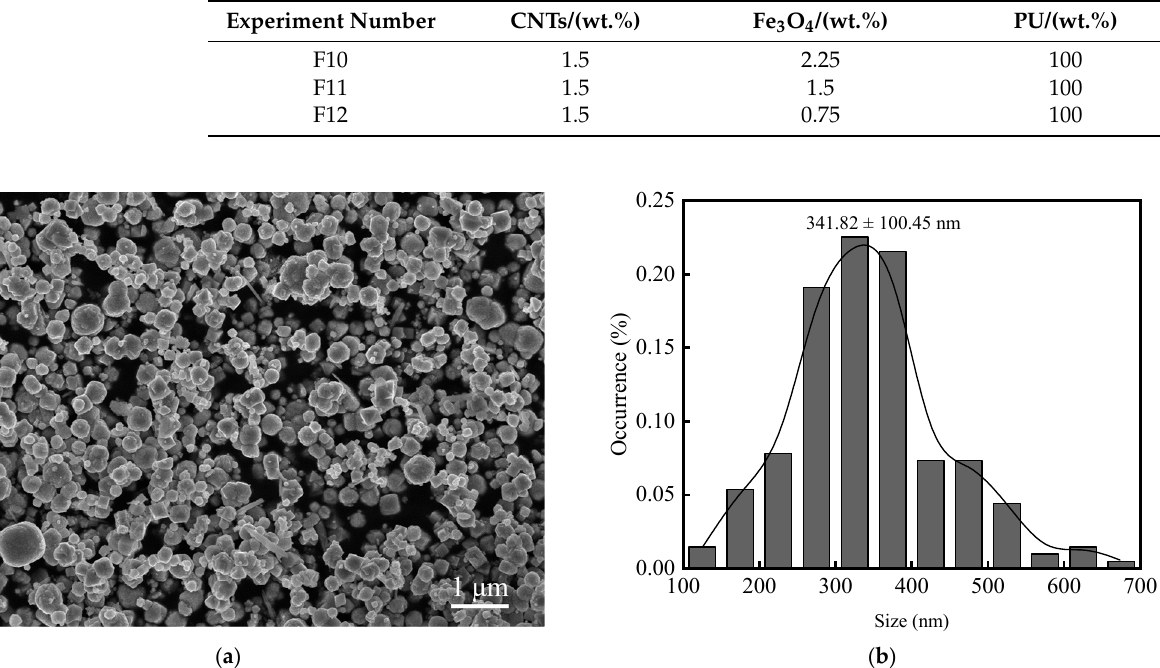
Figure 9. The SEM micrograph and particle size distribution of Fe 3 O 4 powders ( a ) SEM image (WD=9.2 mm, EHT=5.0 kV); ( b ) particle size distribution. Table 4. Experimental scheme for the ratio of Fe 3 O 4 /CNTs.